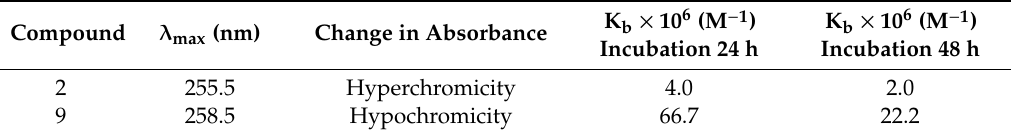
Table 1. K b values of N -butylacridone 2 and N , N (cid:48) -dibutyl-9,9 (cid:48) -biacridylidene 9 and the observed change in UV–Vis absorption spectra after incubation with CT-DNA for 24 and 48 h